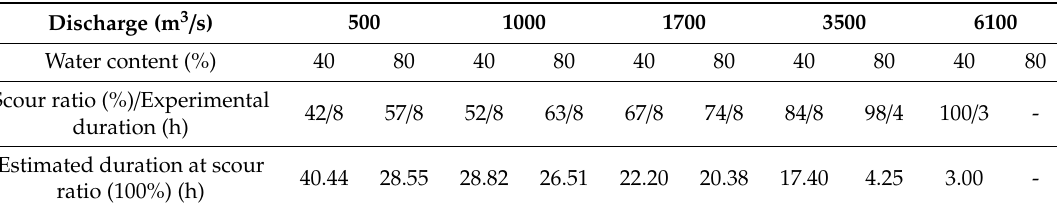
Figure 11. Trend of the scour ratio against time for sediment with the water content of 40% at various reservoir flood discharges.